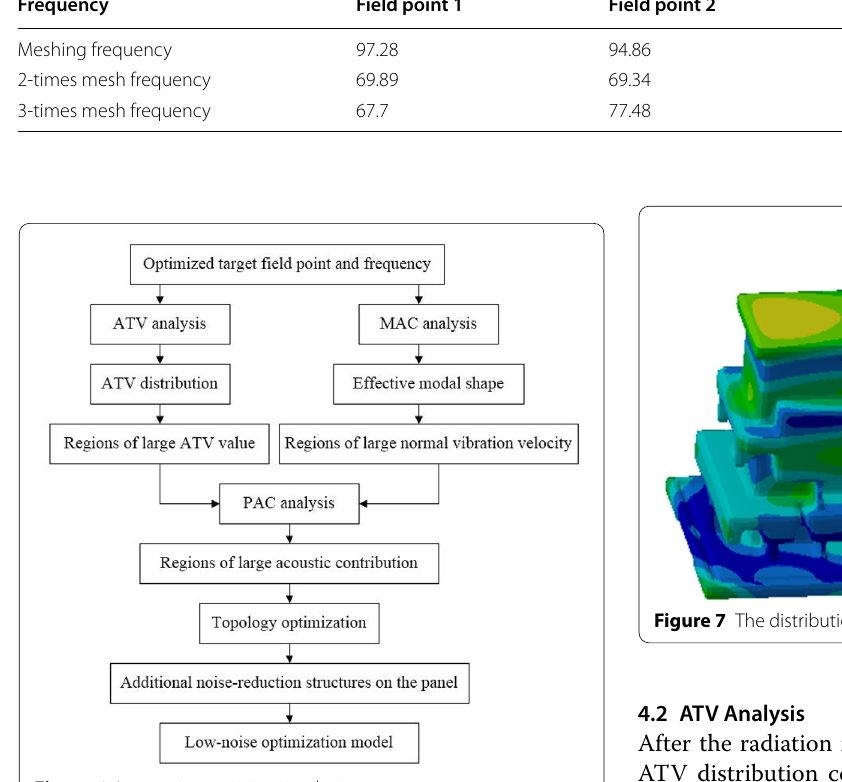
Figure 6 Low-noise optimization design process